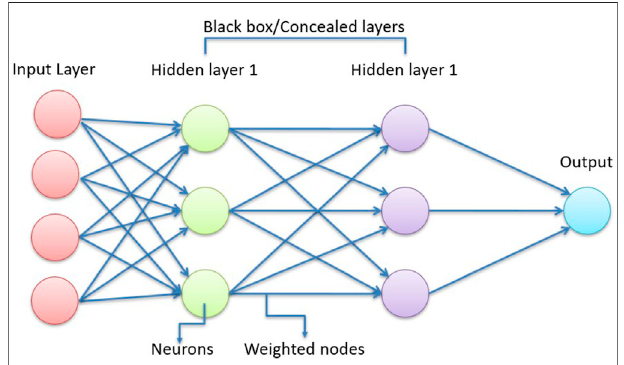
FIGURE 2 | Architecture of the ANN